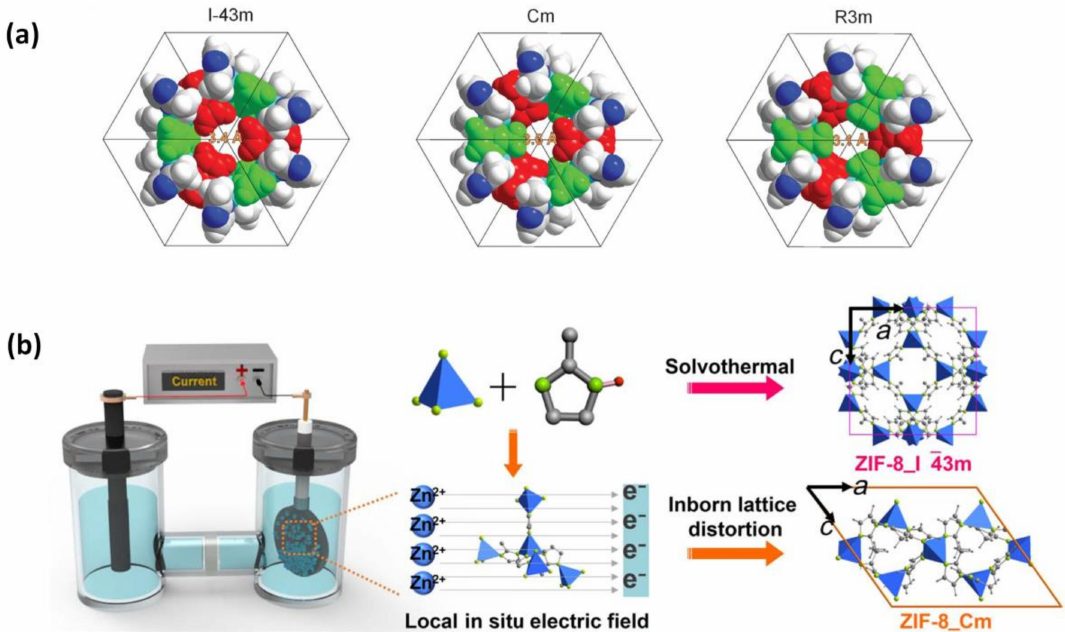
Figure 9. ( a ) The representation of the ZIF-8 gate as a space-filling model of the different simulated polymorphs [108]. ( b ) Schematic illustration of the ZIF-8 membrane growth by FCDS method in comparison with solvothermal growth. The support serves as a cathode in the electrochemcial system [109].